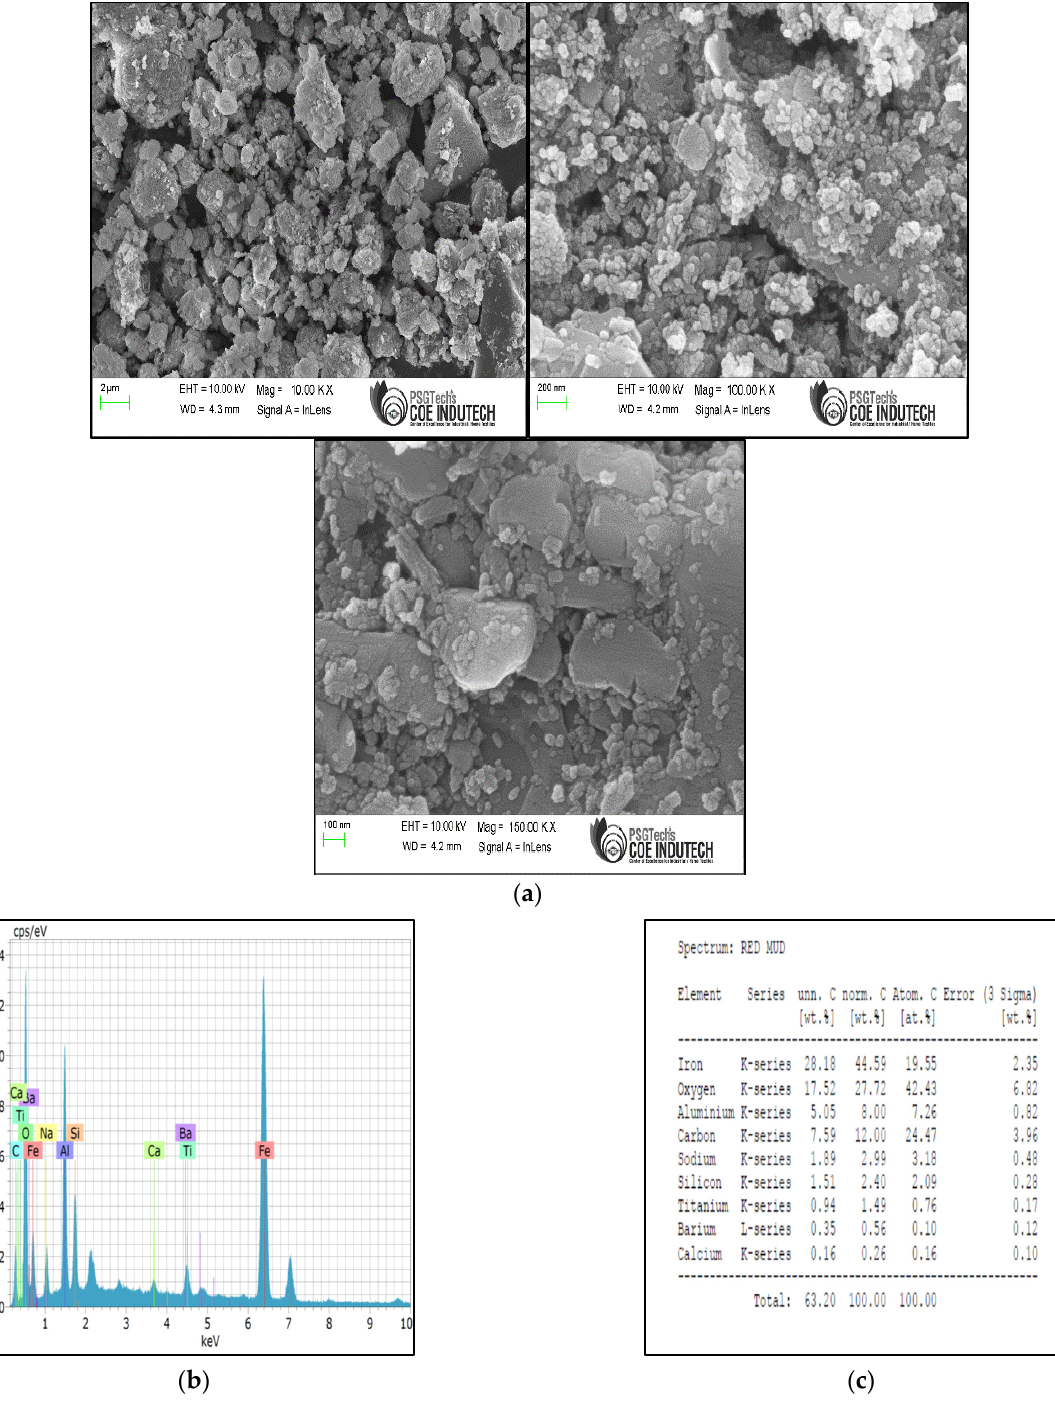
Figure 2. ( a ) Field emission scanning electron microscope images of red mud. ( b , c ) Energy dispersive X-ray analysis of red mud.